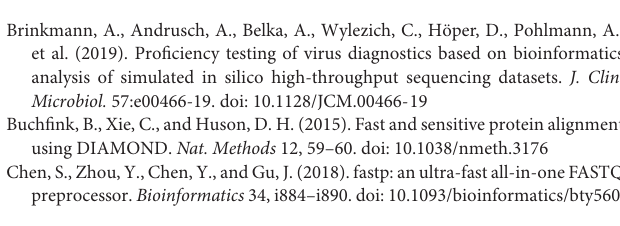
Supplementary Figure 1 | Specificities of read assignments calculated from the complete read set based on the species assignments. Sequences of the taxa labeled gray ( Brugia malayi , Caenorhabditis remanei , Danio rerio , and Scomber japonicus ) were downloaded unintentionally as part of the Anisakis sequence dataset. Supplementary Figure 2 | Correct classification rates of read assignments calculated from the complete read set based on the species assignments. Sequences of the taxa labeled gray ( Caenorhabditis remanei , Brugia malayi , Danio rerio , and Scomber japonicus ) were downloaded unintentionally as part of the Anisakis sequence dataset. Supplementary Figure 3 | Negative predictive values of read assignments calculated from the complete read set based on the species assignments. Sequences of the taxa labeled gray ( Caenorhabditis remanei , Brugia malayi , Danio rerio , and Scomber japonicus ) were downloaded unintentionally as part of the Anisakis sequence dataset. Supplementary Materials and Methods | Emails with requirements to participants and details on the calculation of sensitivity, specificity,